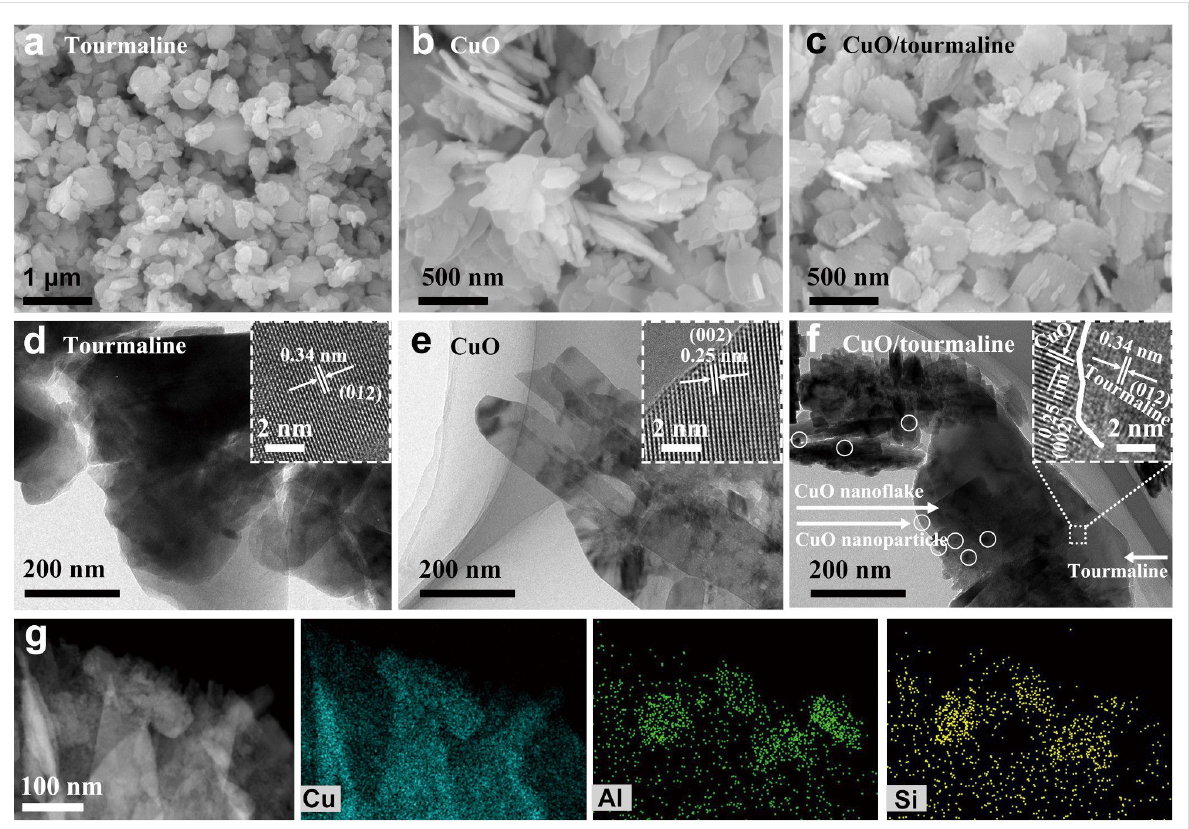
Figure 3: SEM images of (a) tourmaline, (b) CuO, and (c) CuO/tourmaline composite. TEM images of (d) tourmaline, (e) CuO, and (f) CuO/tourma- line composite, where the insets show the corresponding high-resolution TEM images. (g) EDX element mapping images of Cu, Al, and Si for the CuO/tourmaline composite.